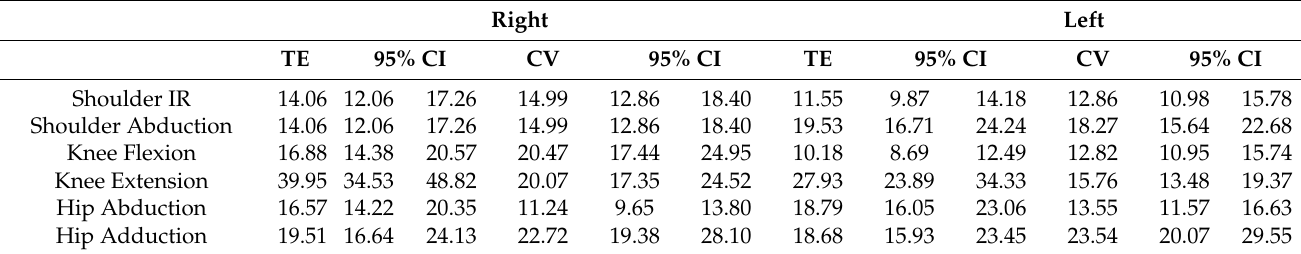
Table 2. Absolute interrater reliability for shoulder, knee, and hip isometric strength.